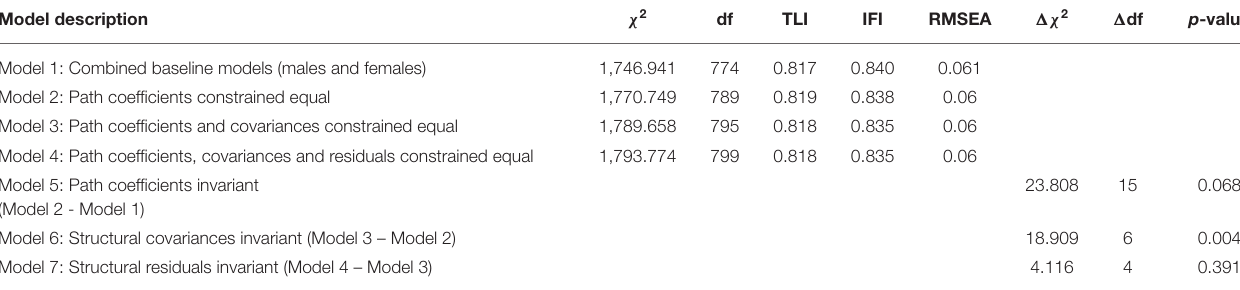
TABLE 7 | Invariance analysis across males and females in the structural model. Model description